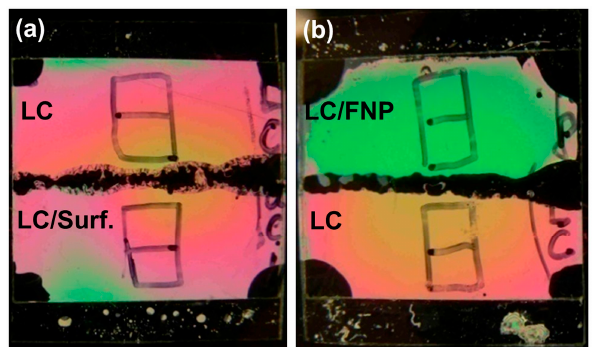
Figure 4. The twin cell placed in between two crossed polarizers: ( a ) the cell is filled with pure liquid crystals (this region is marked as “LC”) and liquid crystals doped with surfactant (oleic acid) (this region is marked as “LC/Surf.”); ( b ) the cell is filled with pure liquid crystals (marked as “LC”) and liquid crystals doped with ferroelectric nanoparticles (marked as “LC/FNP”).